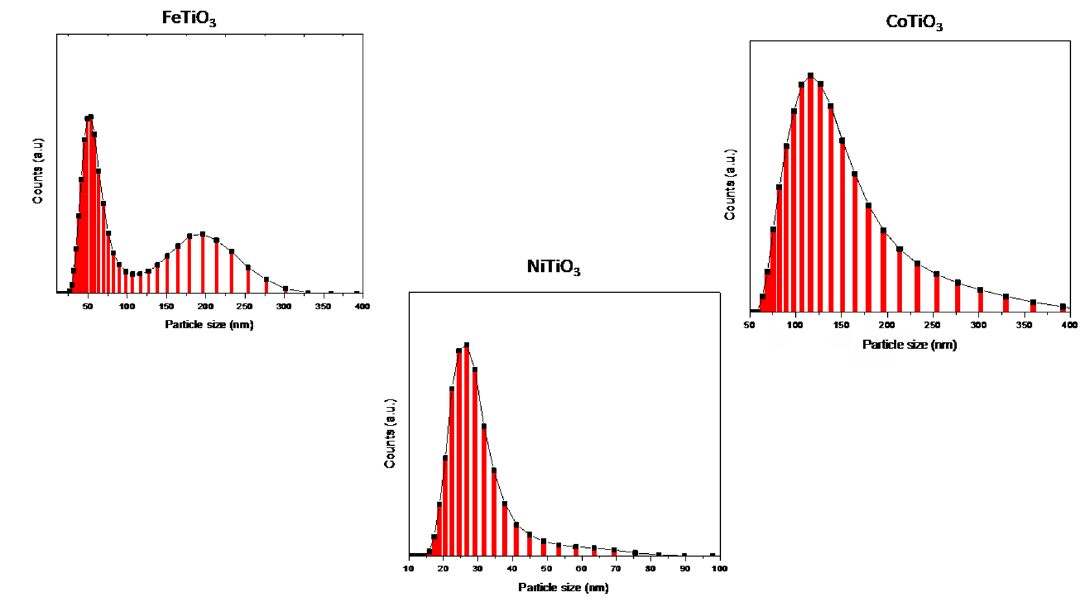
, CoTiO , and NiTiO sinthesized by solvo-combustion method. 3 3 3